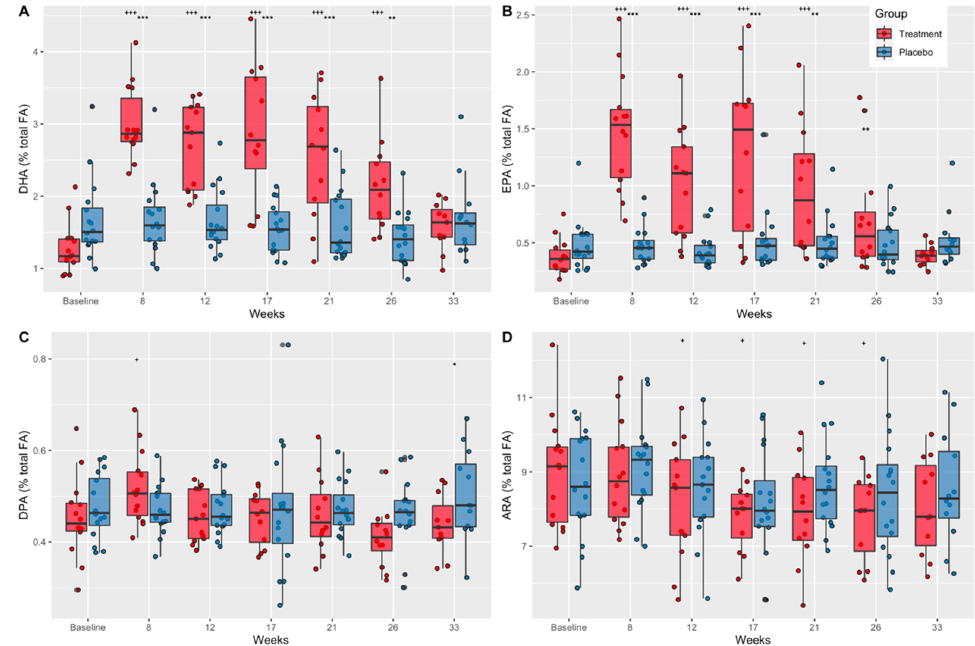
Figure 3. The effect of DHA+EPA supplementation on plasma fatty acid concentrations as a percent of total fatty acids. ( A ) DHA concentrations as a percent of total fatty acids in treatment and placebo groups from baseline through week 33. ( B ) EPA concentrations as a percent of total fatty acids in treatment and placebo groups from baseline through week 33. ( C ) DPA concentrations as a percent of total fatty acids in treatment and placebo groups from baseline through week 33. ( D ) ARA concentrations as a percent of total fatty acids in treatment and placebo groups from baseline through week 33. DHA, docosahexaenoic acid; EPA, eicosapentaenoic acid; DPA, docosapentaenoic acid; ARA, arachidonic acid; p -values show significance between groups (*) and within groups from baseline values (+) according to repeated measures ANOVA and estimated marginal means; p -values: * + p < 0.05; ** ++ p < 0.01, *** +++ p < 0.001, and **** ++++ p < 0.001.